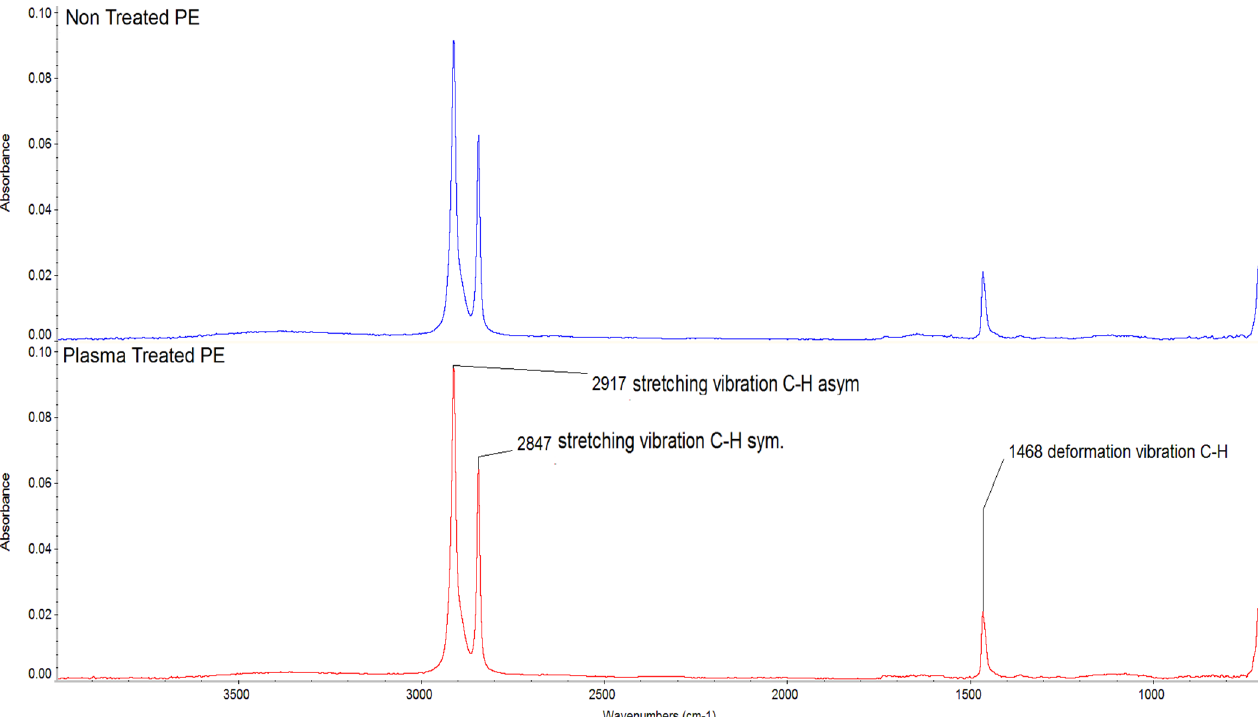
Figure 17. FTIR results for non-treated and plasma-treated PE